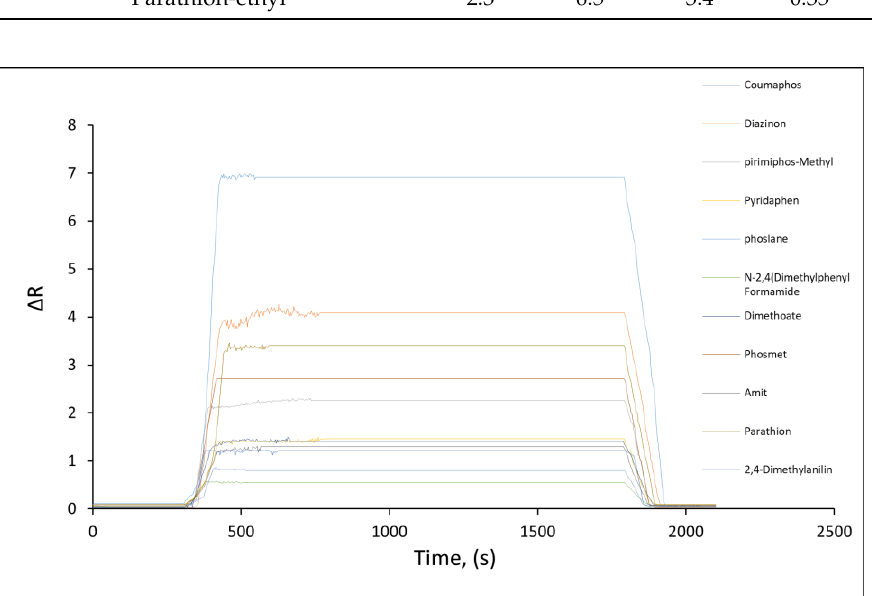
Figure 6. Selectivity studies of CIP-SPR nanosensor using different competitor molecules: diazinon, pirimiphos- methyl, pyridaphenthion, phosalone, N -(2,4-dimethylphenyl)formamide, 2,4-dimethylaniline, dimethoate, phosmet, amitraz, and parathion-ethyl (C: 50 ppb, pH 7.4, t: 25 °C). Table 3. Selectivity coefficient.